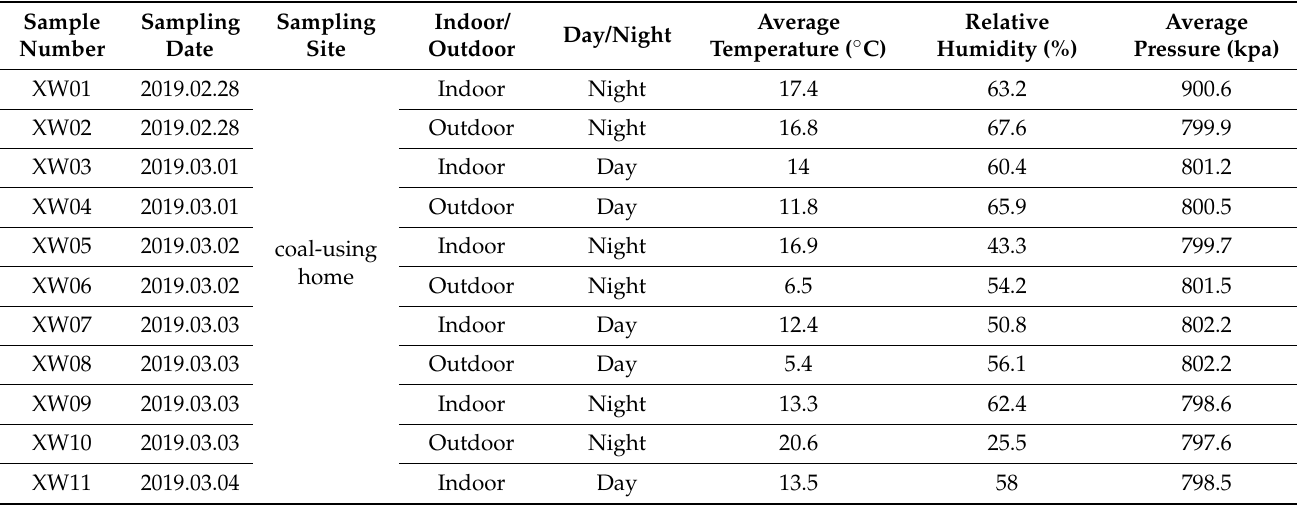
Table 1. Sampling information and meteorological conditions during the sampling periods in the two homes of the Hutou village of the Laibin town, Xuanwei city.